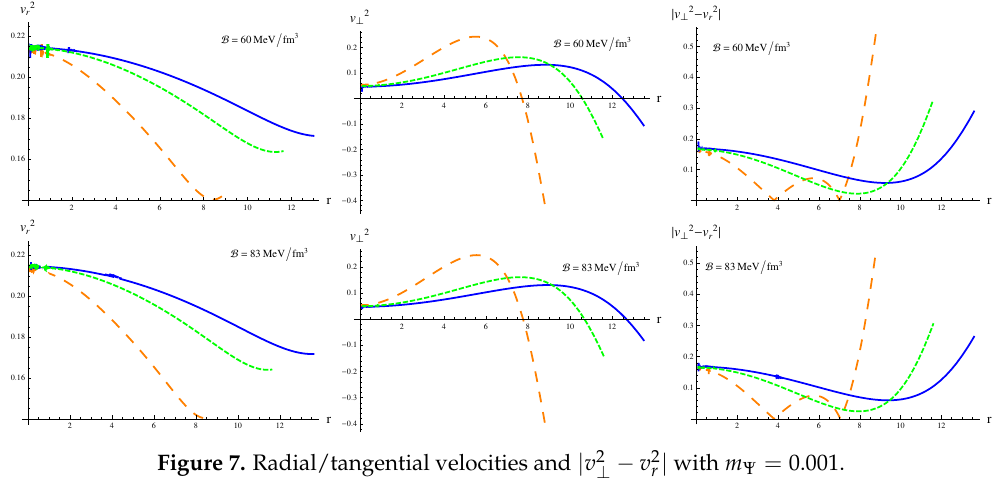
Figure 7. Radial/tangential velocities and | v 2 ⊥ − v 2 r | with m Ψ = 0.001.